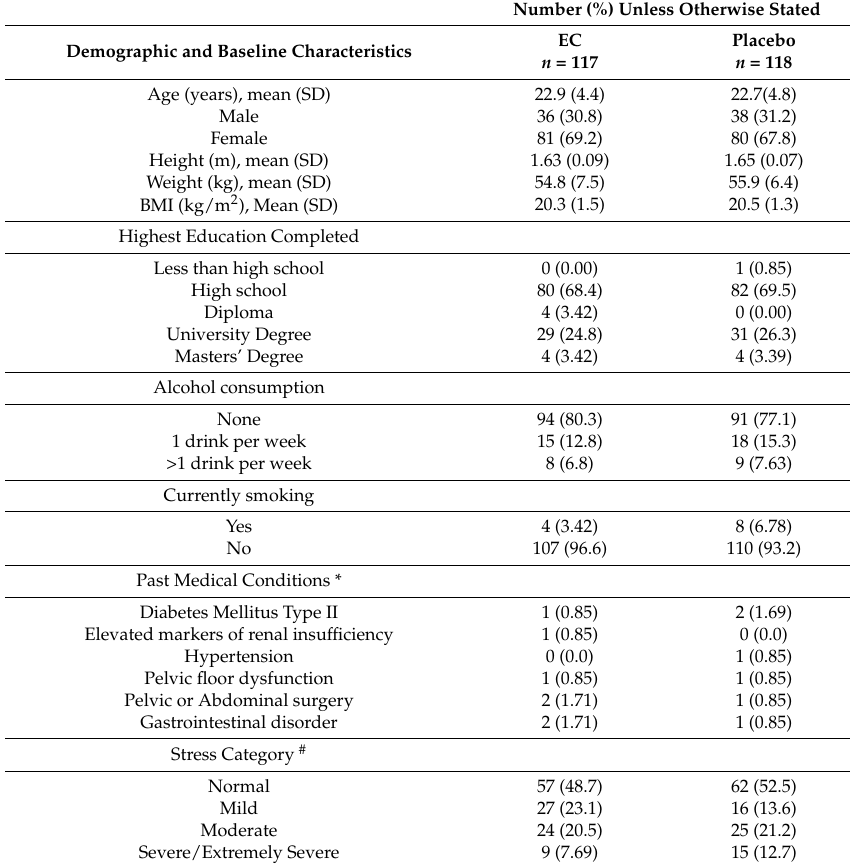
Table 2. Participant demographic, lifestyle and past medical conditions recorded at baseline